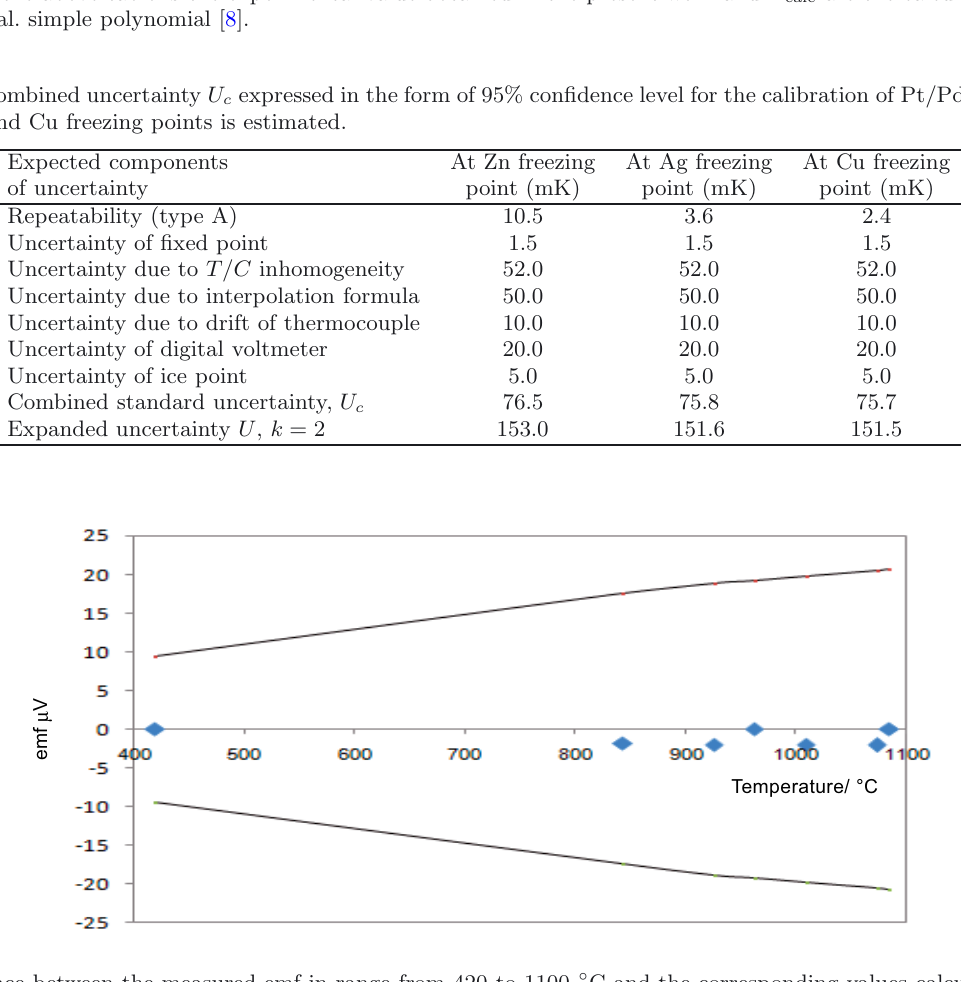
Fig. 4. Difference between the measured emf in range from 420 to 1100 ◦ C and the corresponding values calculated using the reference function by Burns et